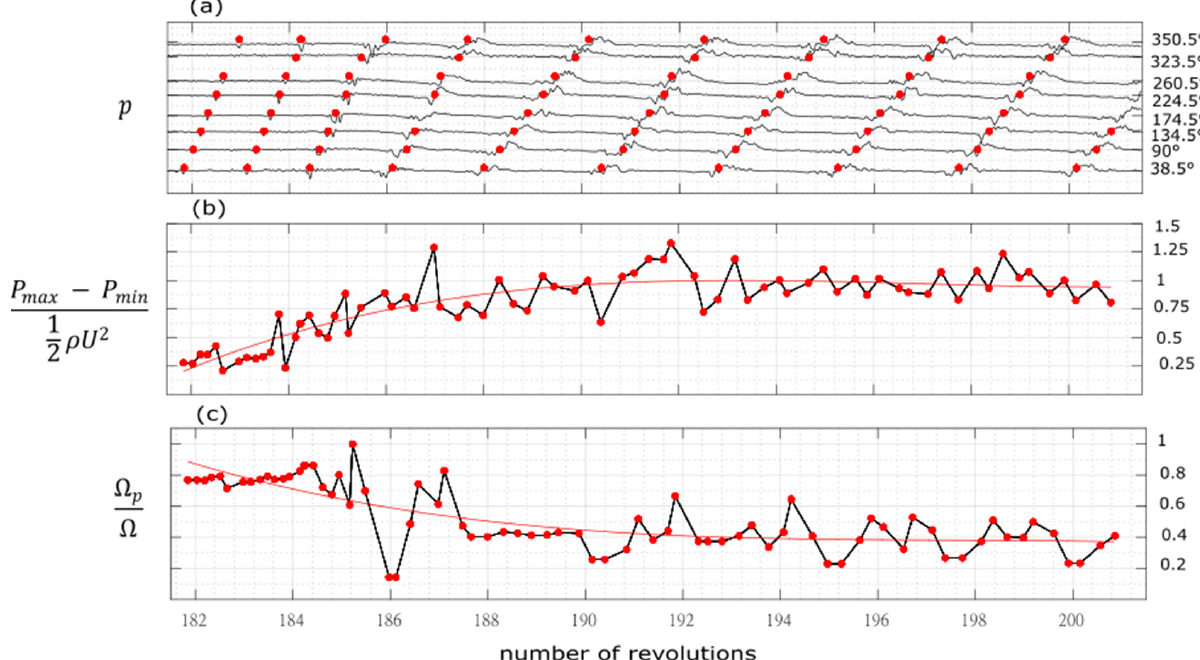
Figure 9. Stall transient with 60° grid; on the x axis the number of revolutions, on the y axis: ( a ) angular position of the signal, ( b ) non-dimensional pressure amplitude, ( c ) non-dimensional perturbation speed.